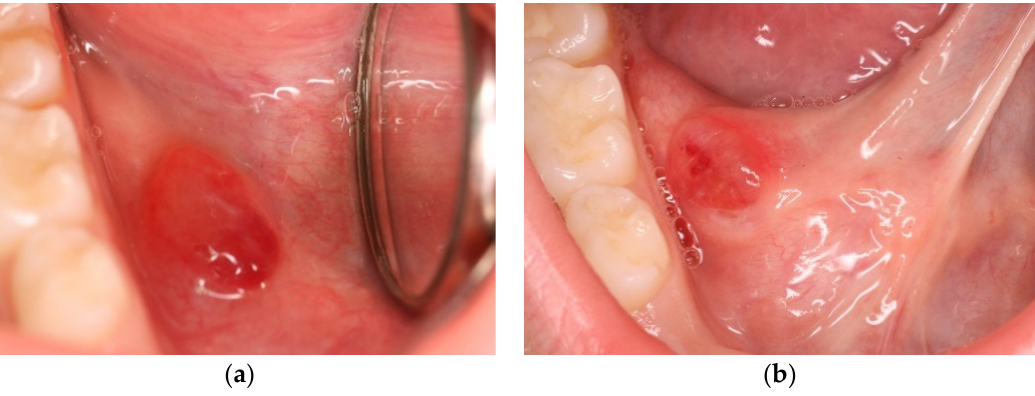
Figure 1. Intraoral physical examination. ( a ) Presence of pseudocystic lesion on the right side of the floor of the mouth. ( b ) Clinical evaluation during the tongue elevation phase.